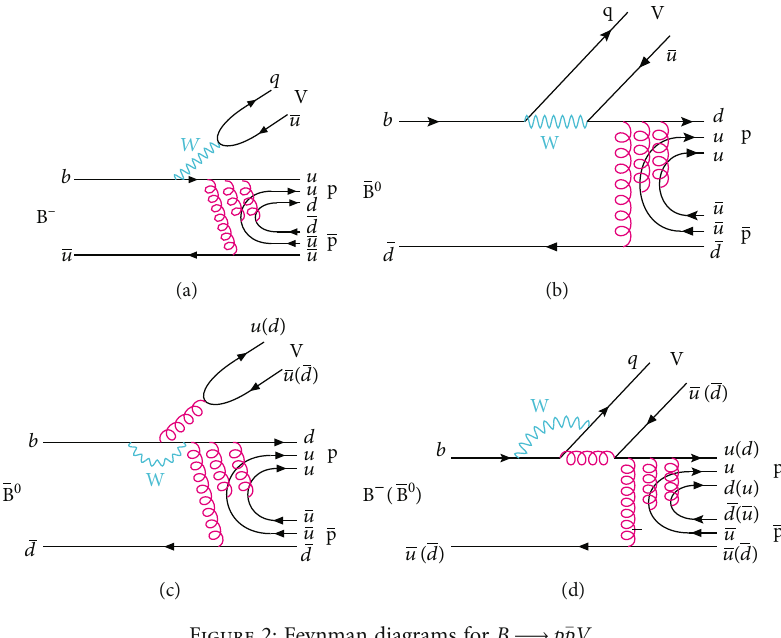
Figure 2: Feynman diagrams for B ⟶ p (cid:1) pV